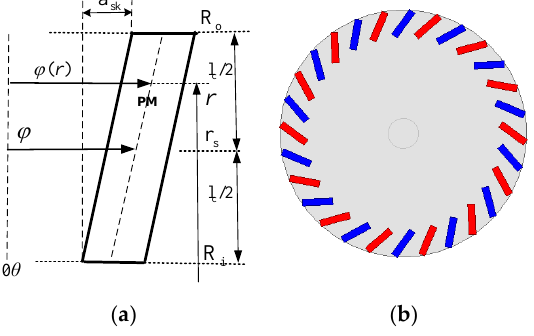
Figure 14. Cross-section of a skewed PM: ( a ) reference frame; ( b ) rotor disc with skewed PM.